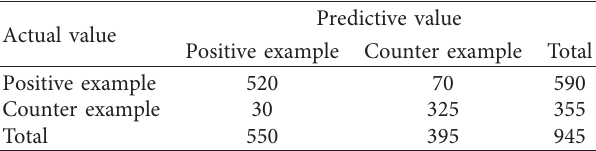
Table 2: Confusion matrix of SVM classification results.